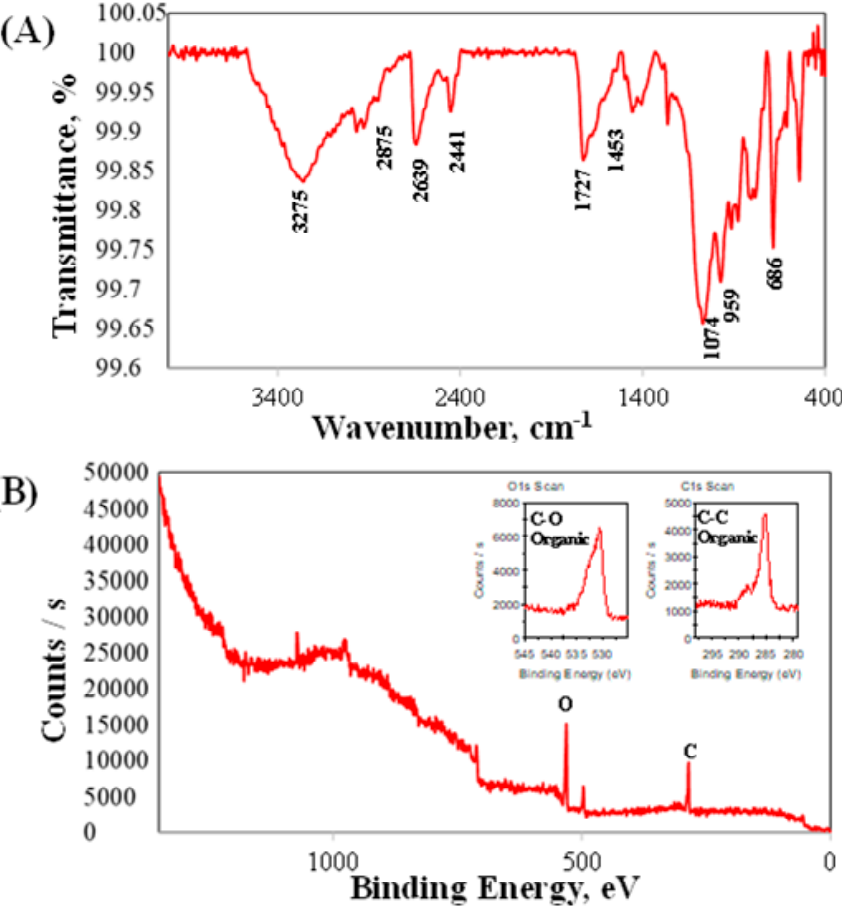
Figure 4. Analysis of chemical composition for the polycaffeic acid coatings: ( A ) FTIR spectra; ( B ) survey spectra of X-ray photoelectron spectroscopy (XPS). The XPS high-resolution O1s